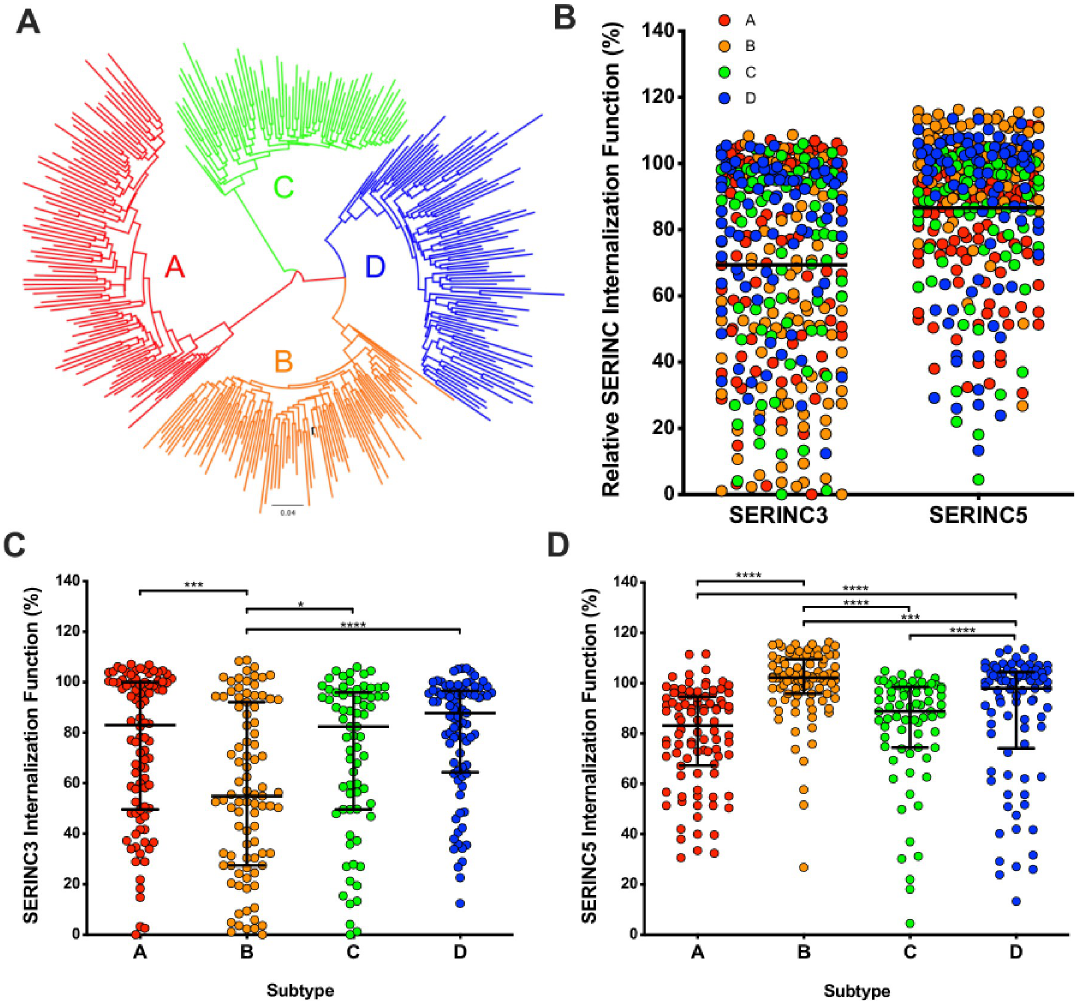
Fig 1. Nef-mediated SERINC3 and SERINC5 internalization function varies among circulating Nef alleles representing globally relevant subtypes. (A) A maximum likelihood phylogenetic tree of 339 participant-derived HIV Nef clones is shown. Subtype A clones are represented in red, subtype B in orange, subtype C in green and subtype D in blue. The subtype B NL4.3 Nef strain (black) was included as a reference. (B) The relative ability of all Nef clones to internalize SERINC3 (left) or SERINC5 (right) is shown. SERINC internalization was assessed by flow cytometry following co-transfection of CEM T-cells with Nef and SERINC(iHA) (also see S1 Fig) , and values were normalized to that of the NL4.3 Nef control (set as 100%). (C) The relative ability of each Nef clone to internalize SERINC3 is shown, stratified by subtype. (D) The relative ability of each Nef clone to internalize SERINC5 is shown, stratified by subtype. Bars represent the median and the interquartile ranges. Statistical analysis was performed using the Mann-Whitney U-test and significant results are indicated by asterisks ( � = p < 0.05; �� = p � 0.01; ��� = p � 0.001; ���� = �